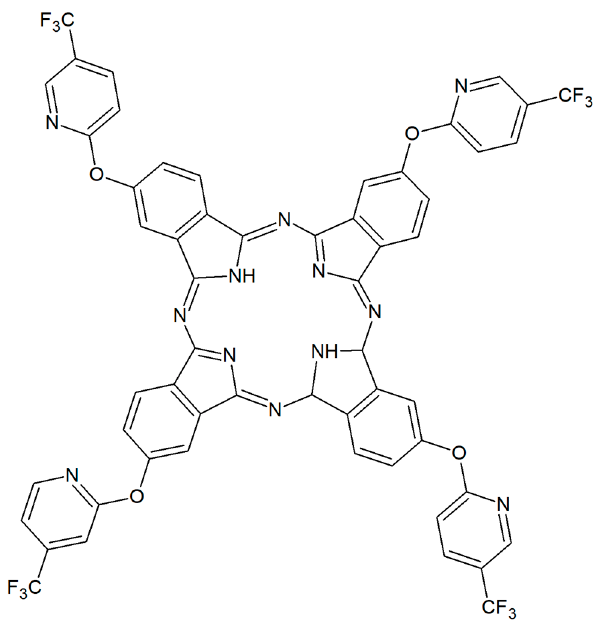
Figure 35. Chemical structure of the free base 4-((5-(trifluoromethyl)pyridin-2-yl)oxy)phthalocyanine utilized to assemble the hybrid structures with GQDs in the ref. [191].